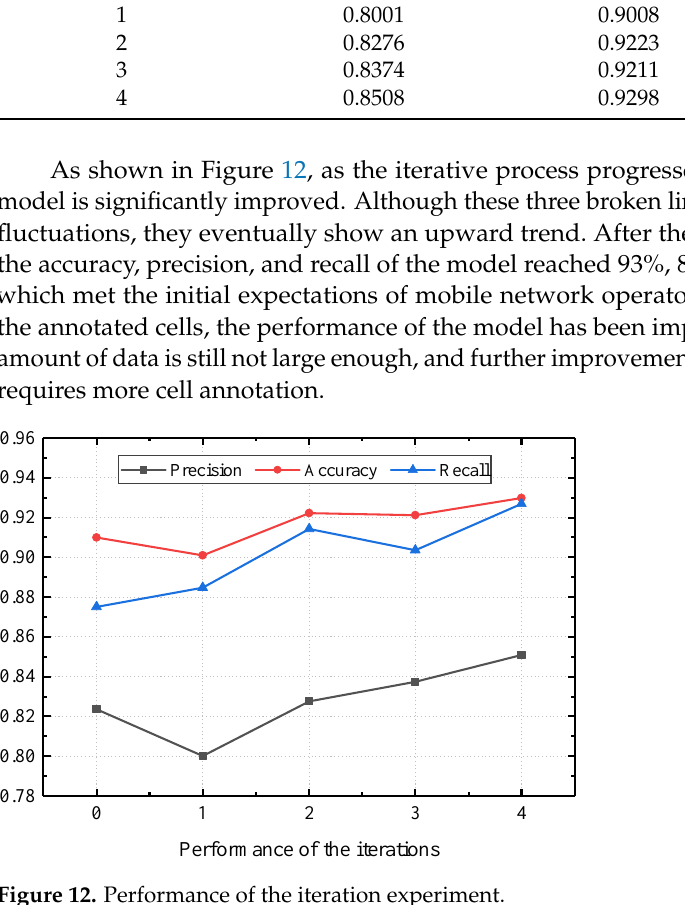
Figure 12. Performance of the iteration